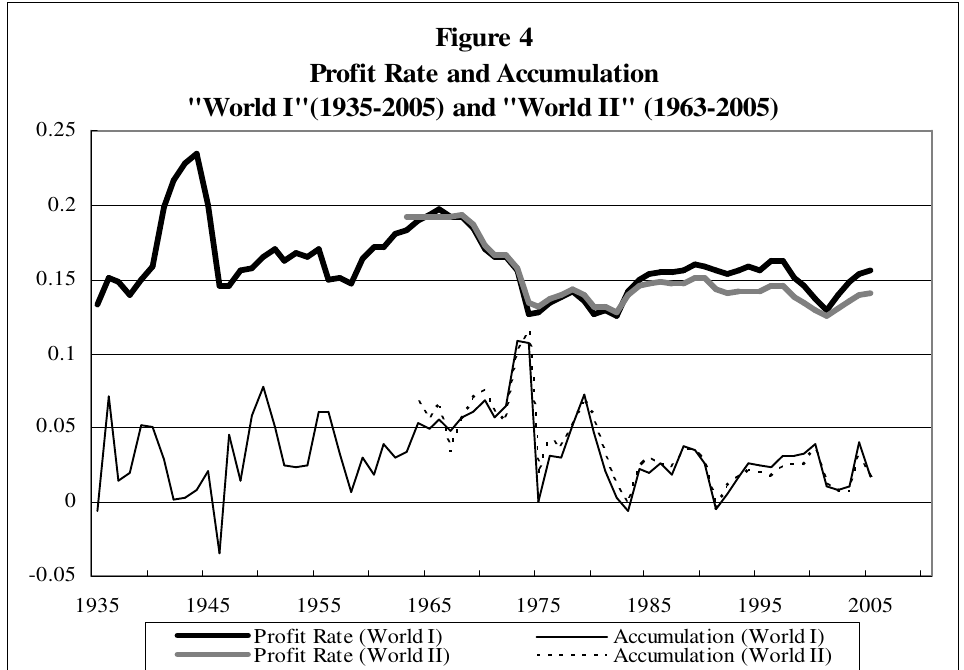
Figure 4 Profit Rate and Accumulation "World I"(1935-2005) and "World II"